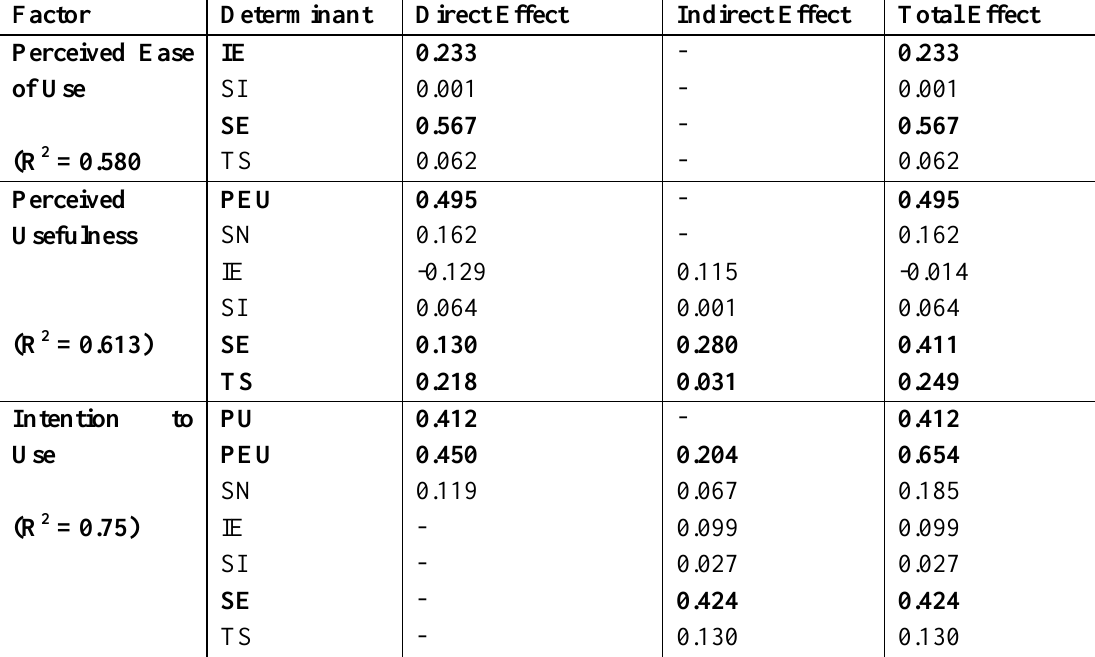
Standardized Causal Effects